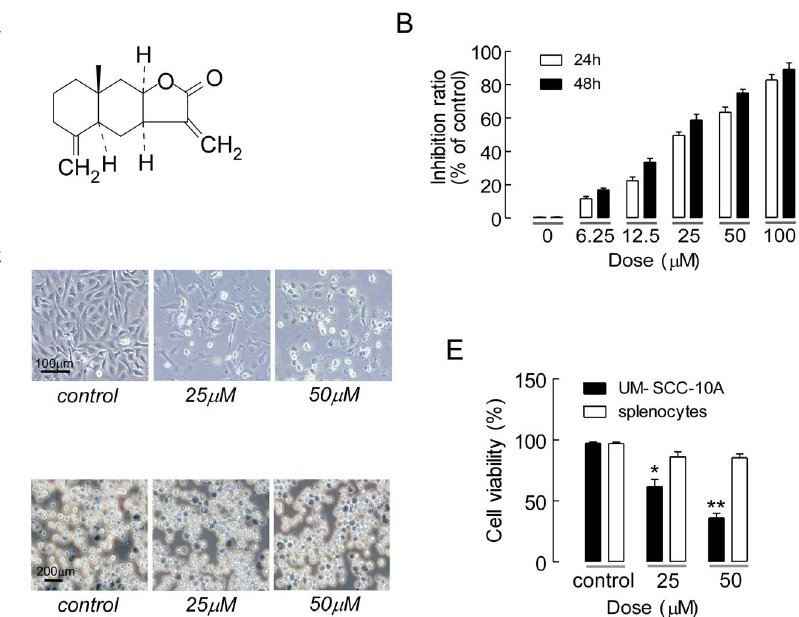
Figure 1. The chemical structure of isoalantolactone and its growth-inhibiting effect on UM-SCC-10A cells and mouse splenocytes. (A) The chemical structure of isoalantolactone. (B) UM-SCC-10A cells were pretreated with 0.1% DMSO or various concentrations of isoalantolactone for 24 and 48 h, and cell growth inhibition assays were performed using the MTT method. The data are expressed as the mean 6 SEM of three independent experiments. (C) Isoalantolactone-induced morphologic changes in the UM-SCC-10A cells, and these changes were observed using inverted phase contrast microscopy. The control cells adhered well and displayed normal UM-SCC-10A cell morphology. After isoalantolactone treatment, many cytoplasmic vacuoles were observed in the cells. The vacuoles became progressively larger and denser with increasing concentrations of isoalantolactone. (D) Mouse splenocytes were treated with 25 and 50 m M isoalantolactone for 24 h and stained with 0.4% trypan blue, after which they were examined for dead and living cells microscopically. The dead cells stained blue. (E) Cell viability after 25 or 50 m M isoalantolactone treatment in UM-SCC-10A cells and mouse splenocytes for 24 h. The results are the mean 6 SEM from three independent experiments. * P , 0.05 and ** P , 0.01 compared to the